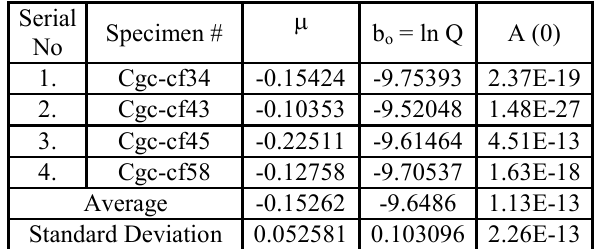
Table 2. Fatigue crack growth parameters for